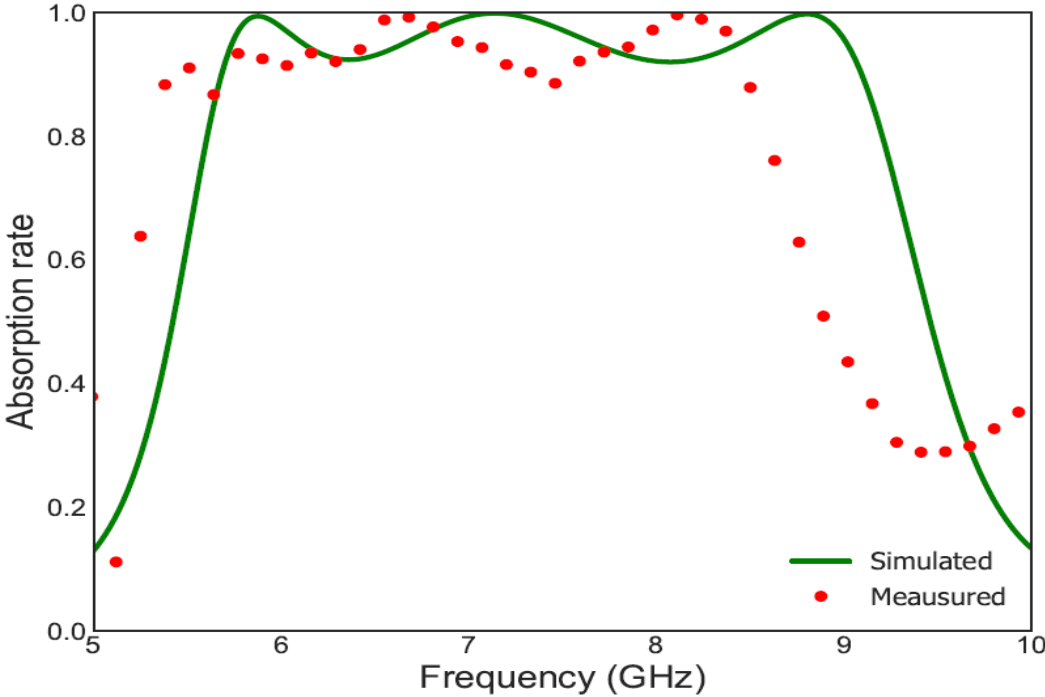
Figure 10. In red circles, the measured absorption rate is plotted and in green the simulated absorption rate is shown. Both are plotted under normal incidence for linearly polarized TE